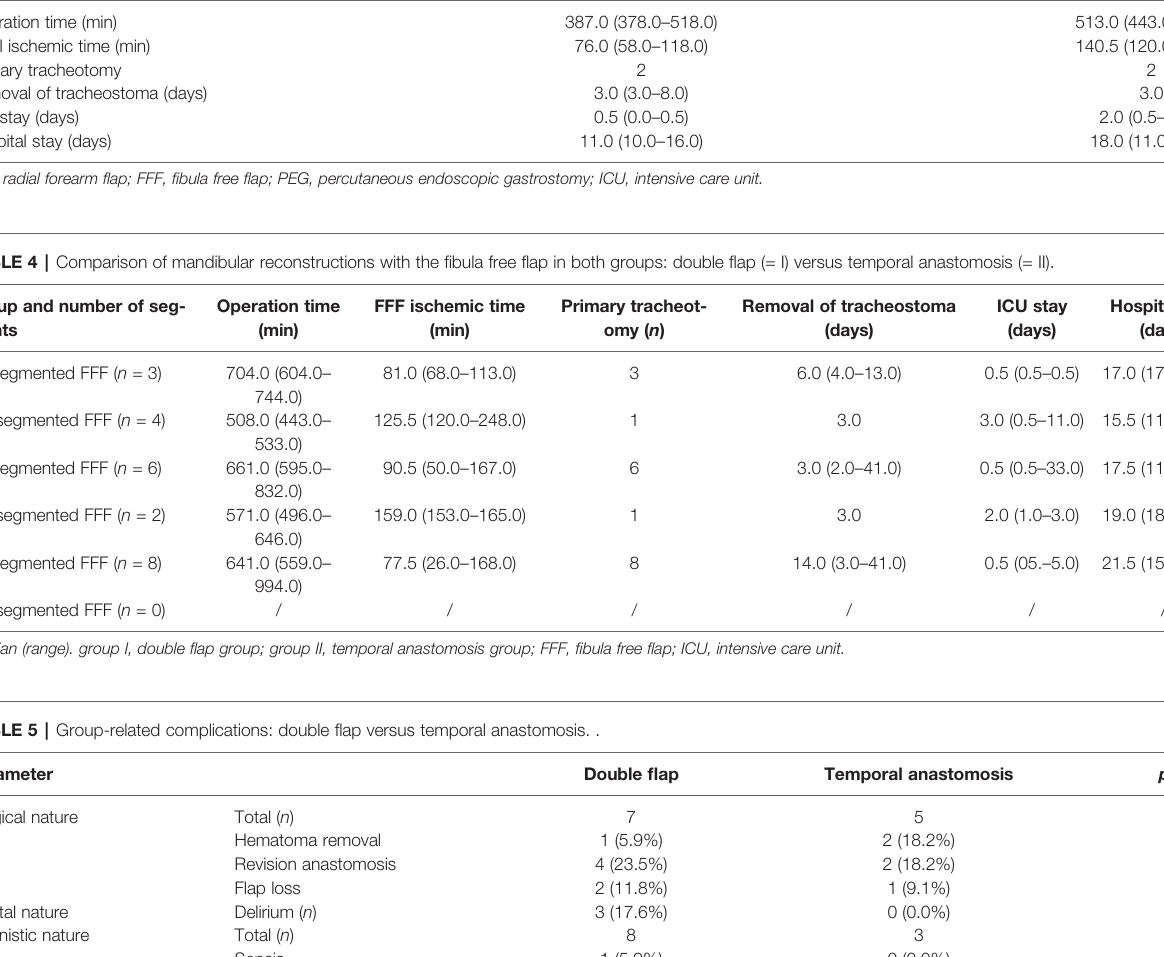
TABLE 3 | Comparison between radial forearm ( n = 5) and free fi bula ( n = 6) fl aps in the group of temporal anastomosis (group II) [incidence or median (range)]. Parameter